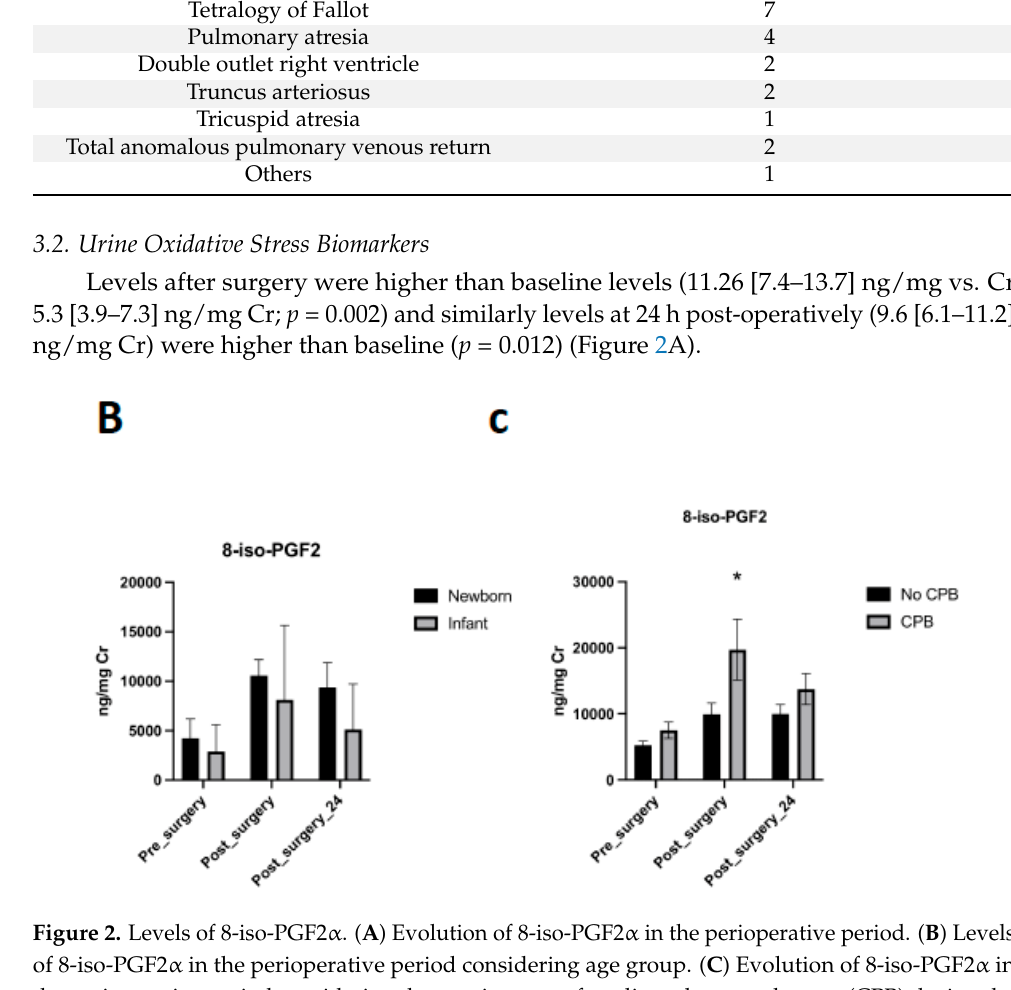
Figure 3. Levels of S100B protein. ( A ) Evolution of S100B protein in the perioperative period. ( B ) Levels of S100B protein depending on the presence of electrical seizures during the surgery.